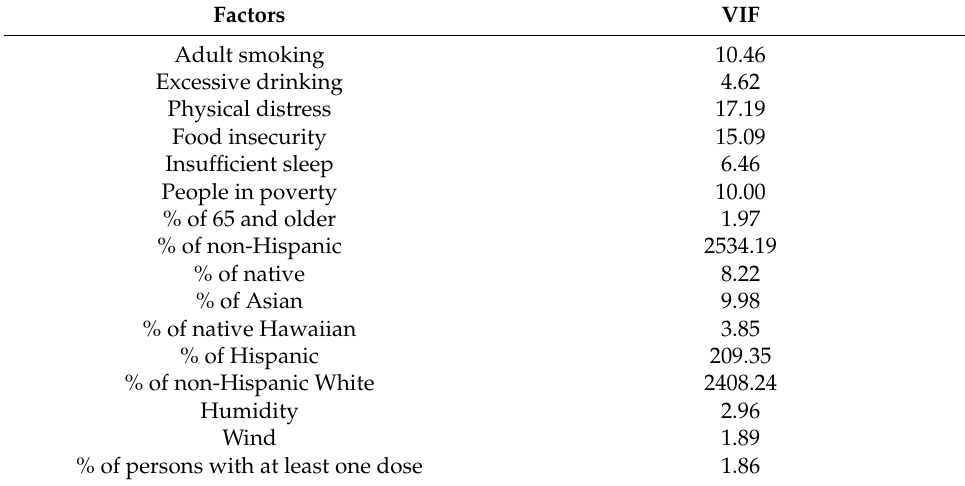
Table A1. VIF values for different variables in 2021 DJF after backward